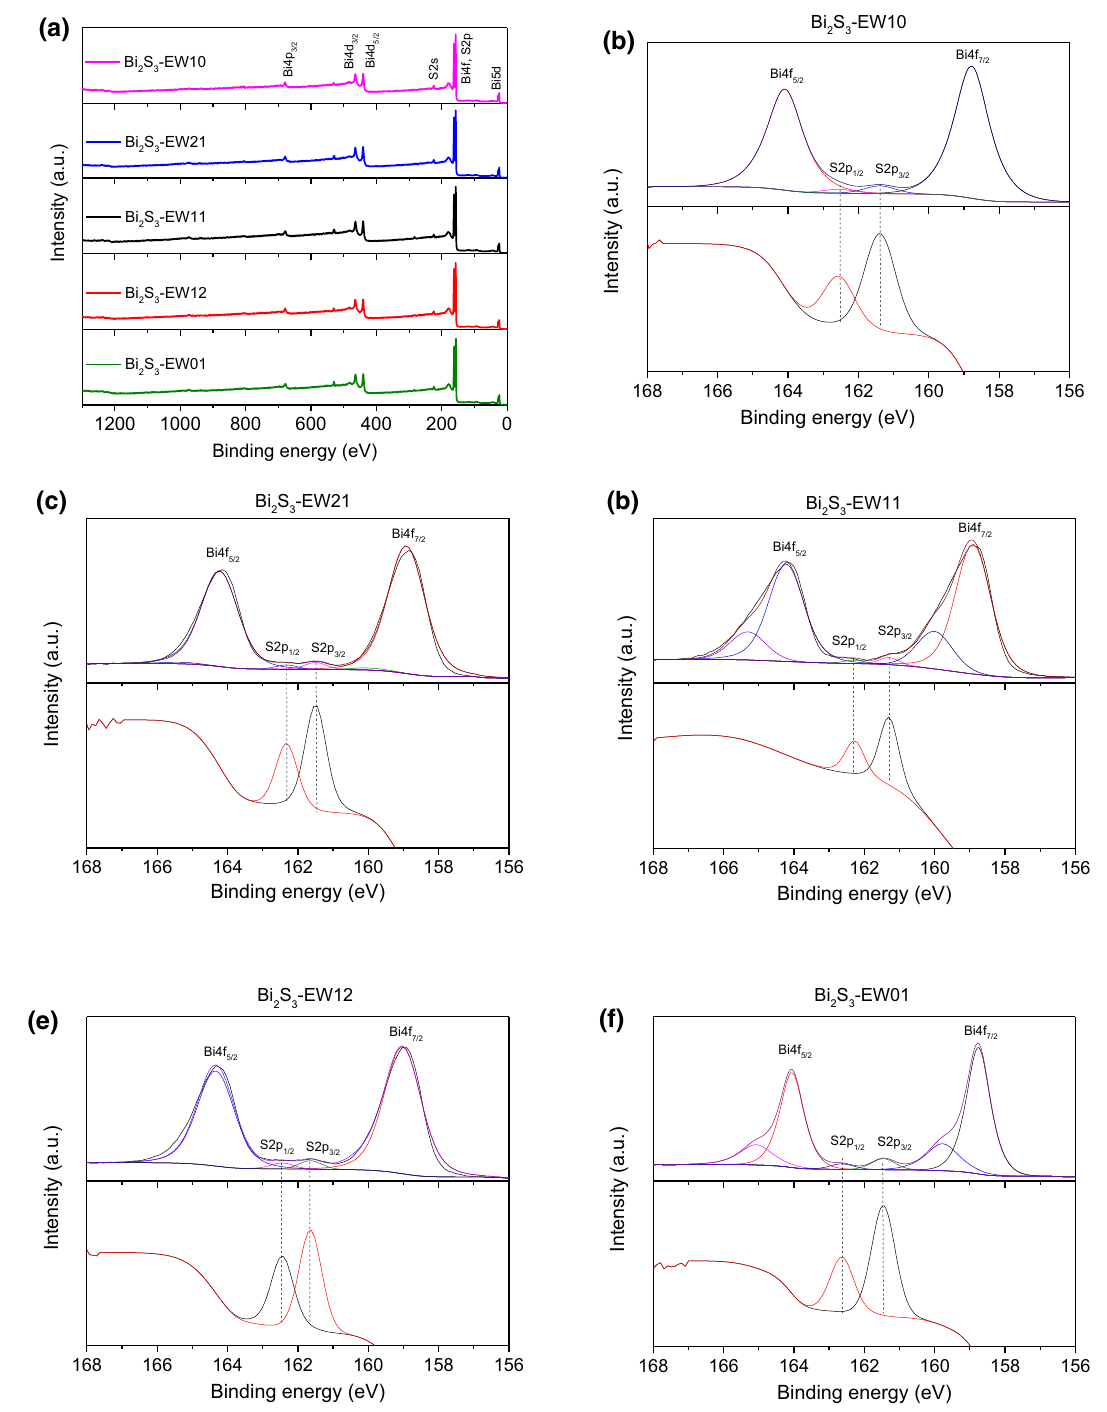
Fig. 4 XPS survey spectra ( a ), and Bi 4f and S 2p regions of Bi